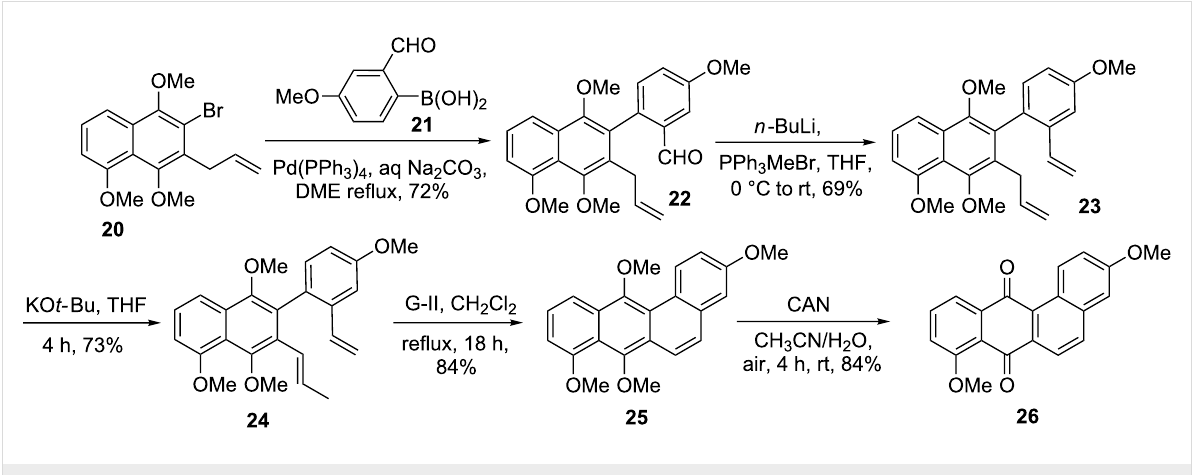
Scheme 3: SM coupling and RCM protocol to the benz[ a ]anthracene skeleton 26 .